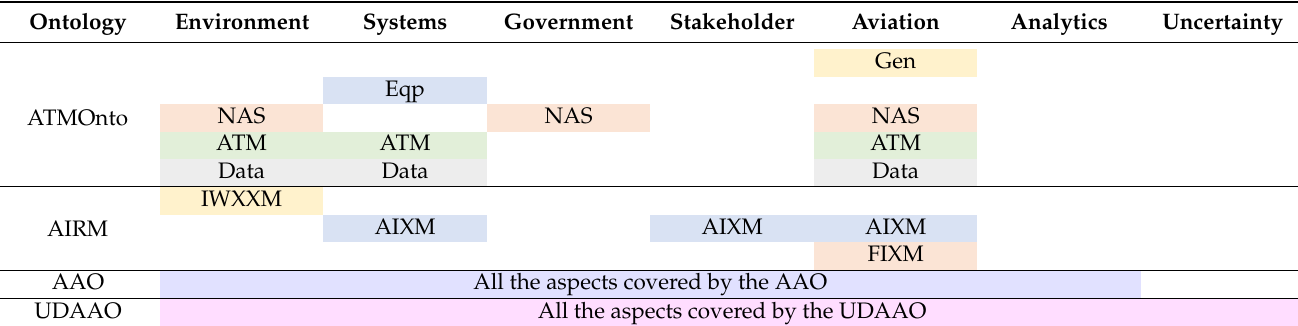
Table 8. Comparison of scopes of relevant